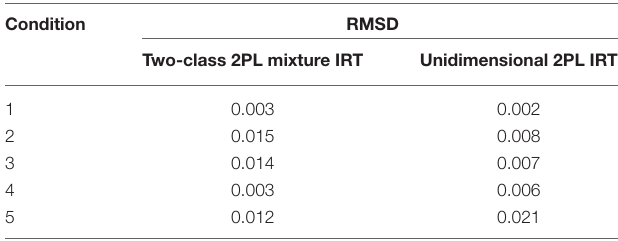
TABLE 12 | Changes in the root mean squared difference (RMSD) of ability using estimated ability across Time 1 and Time 2. Condition